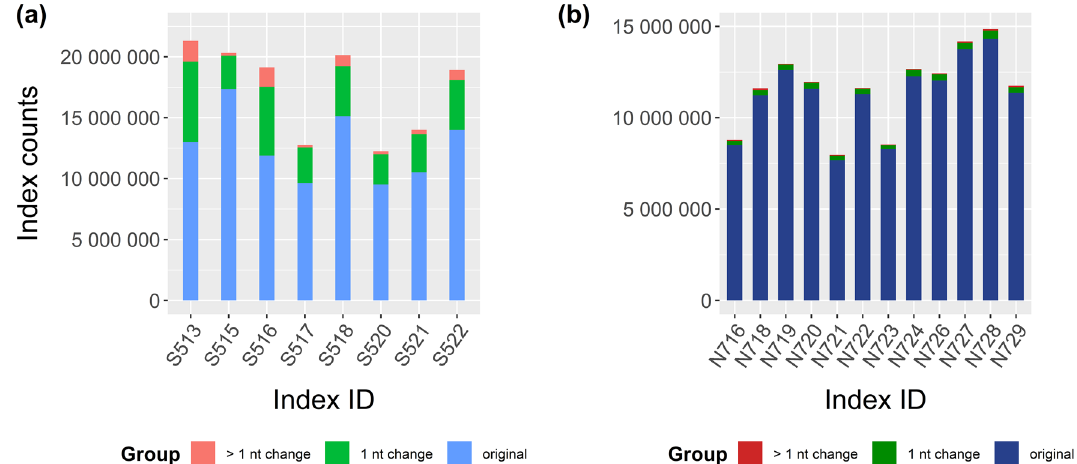
Figure 5. Sequencing error proportions for Nextera index regions ( a ) (S5xx) and ( b ) (N7xx) indexes; counting reads either containing more than one nucleotide differences (> 1 nt change), exactly one nucleotide difference from the original eight nucleotide index region (1 nt change) or no sequencing error within index region (original). Analysed reads were obtained from merged plate